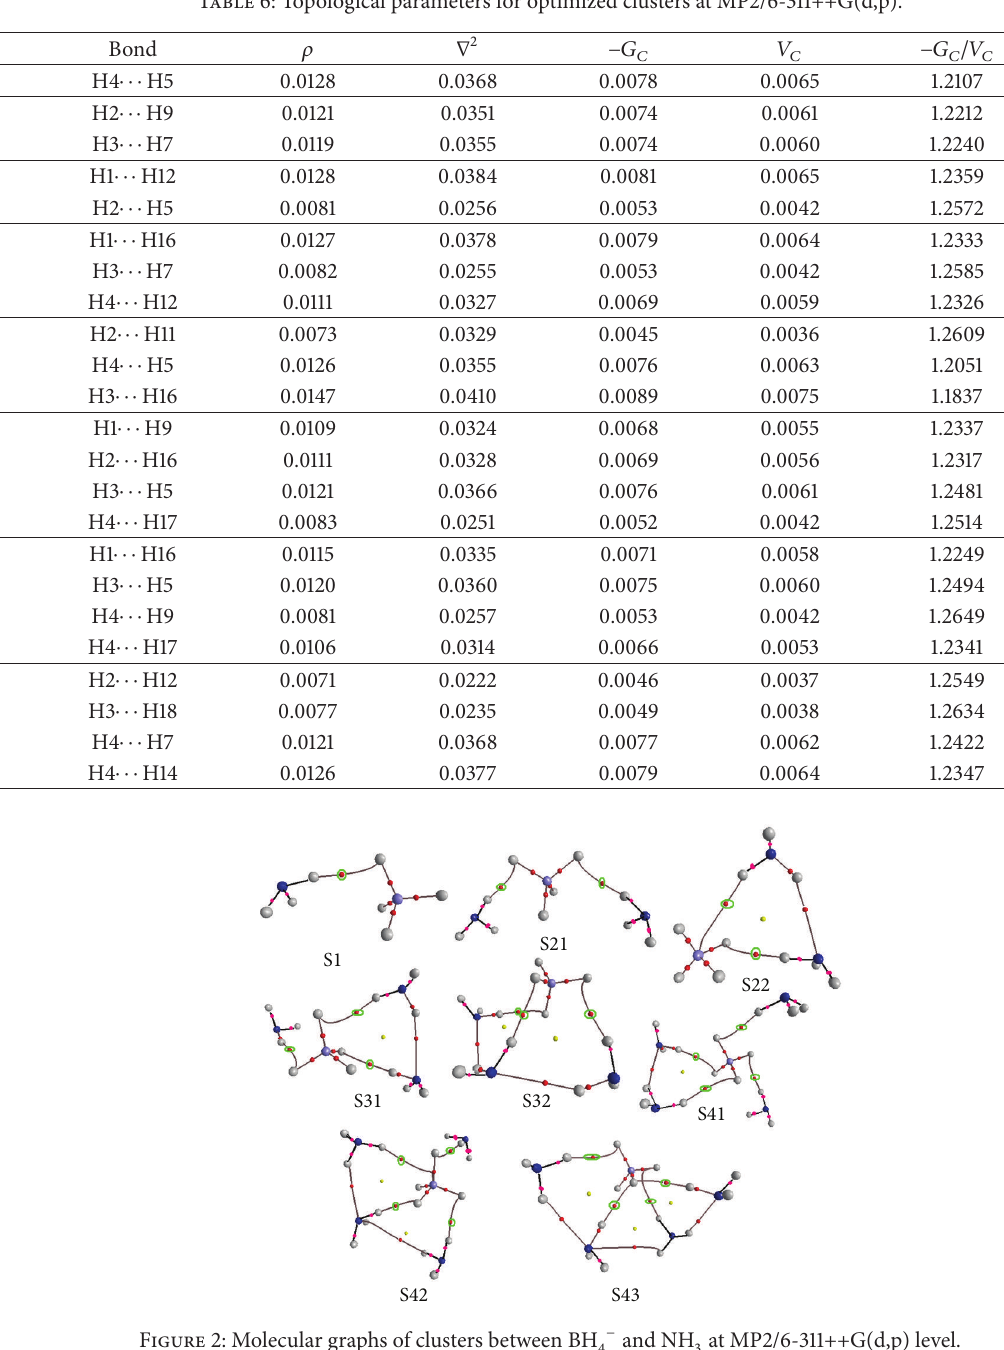
Figure 2: Molecular graphs of clusters between BH 4− and NH 3 at MP2/6-311++G(d,p)